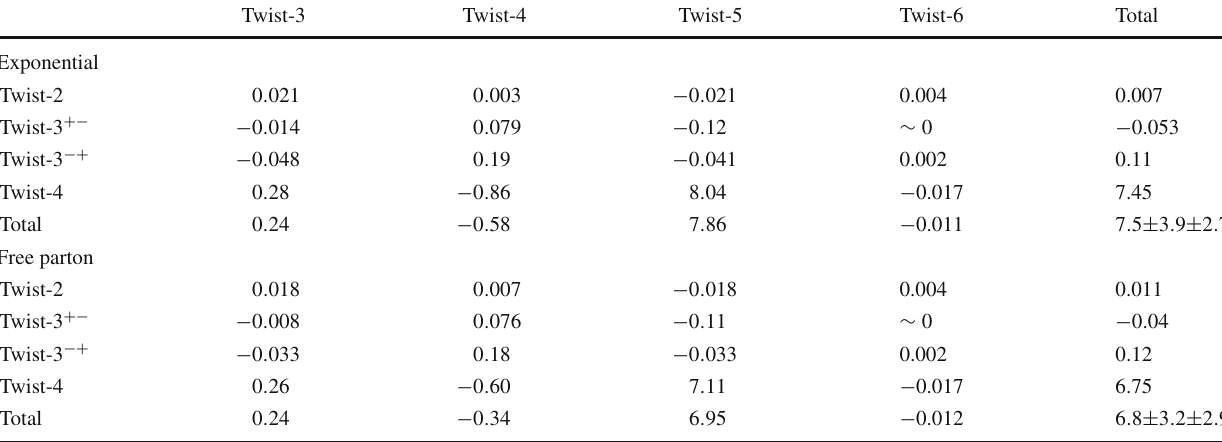
Table 7 The same as Table 4 but for the form factor f 2 ( 0 ) in unit of 10 − 3